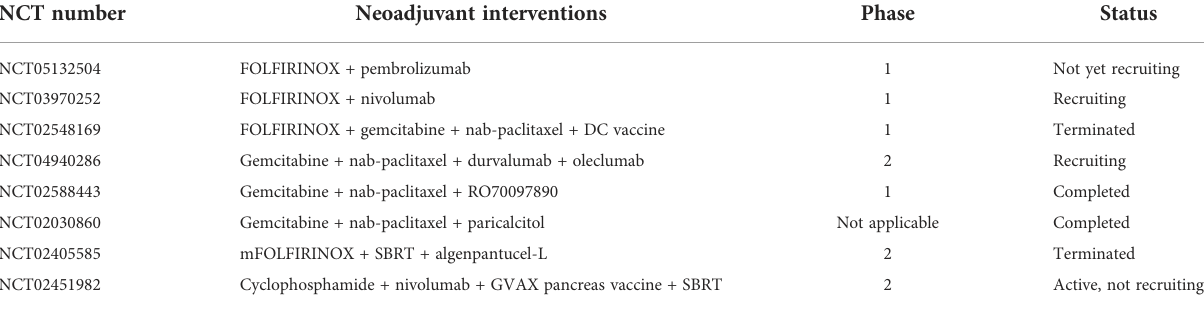
TABLE 1 Clinical trials of neoadjuvant chemotherapy or chemoradiotherapy combined with immunotherapy. NCT